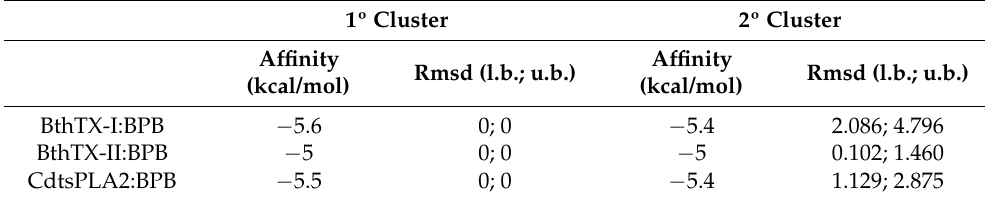
Table 2. Binding free energy (affinity) and rmsd values of each toxin with BPB. 1º